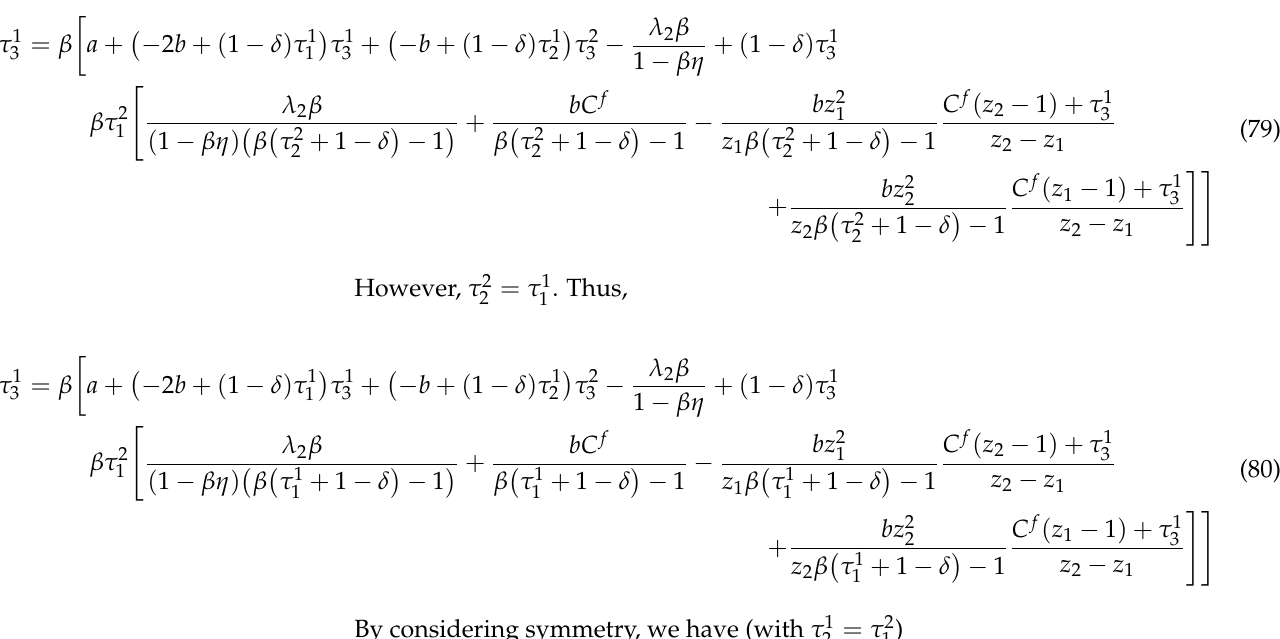
= τ 2 depending on λ 2 = γ 2 , where tau3 denotes τ 1 3 3